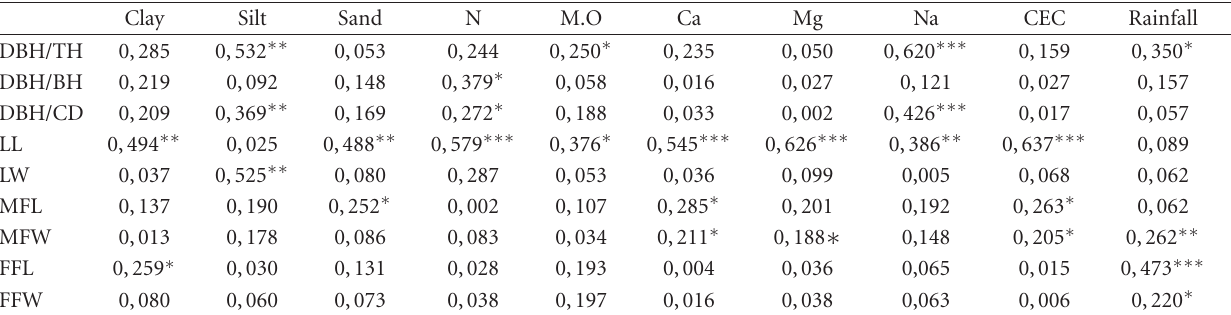
Table 5: Coe ffi cient of determination ( R 2 ) of the linear regressions of morphometric traits on environmental variables.